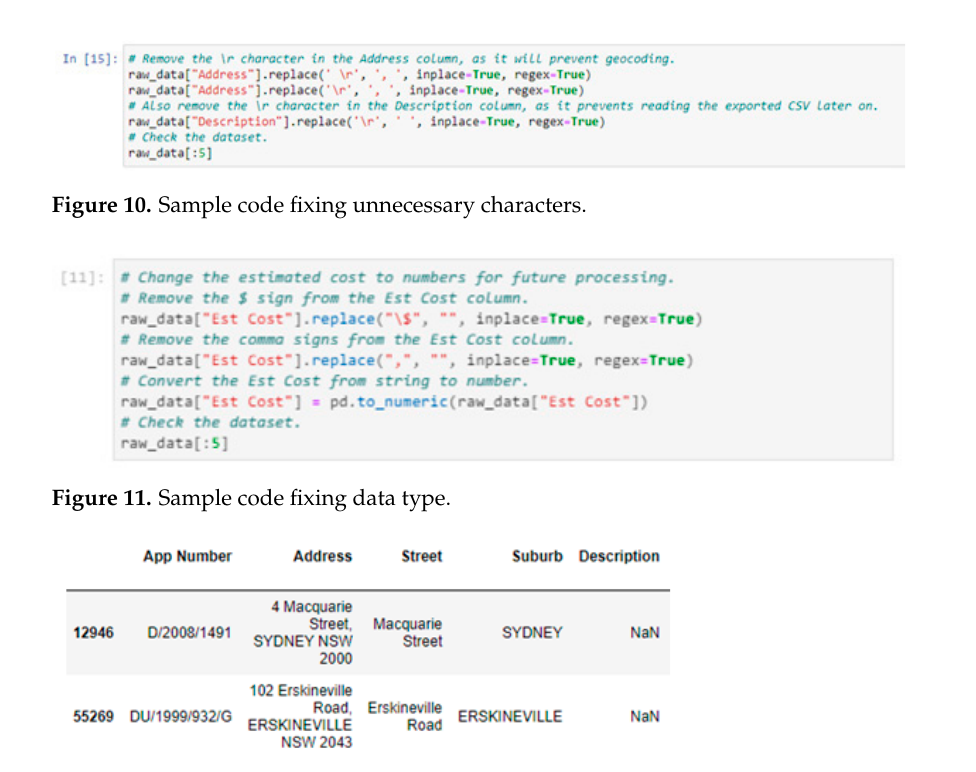
Figure 12. Entries with null value for the description field.